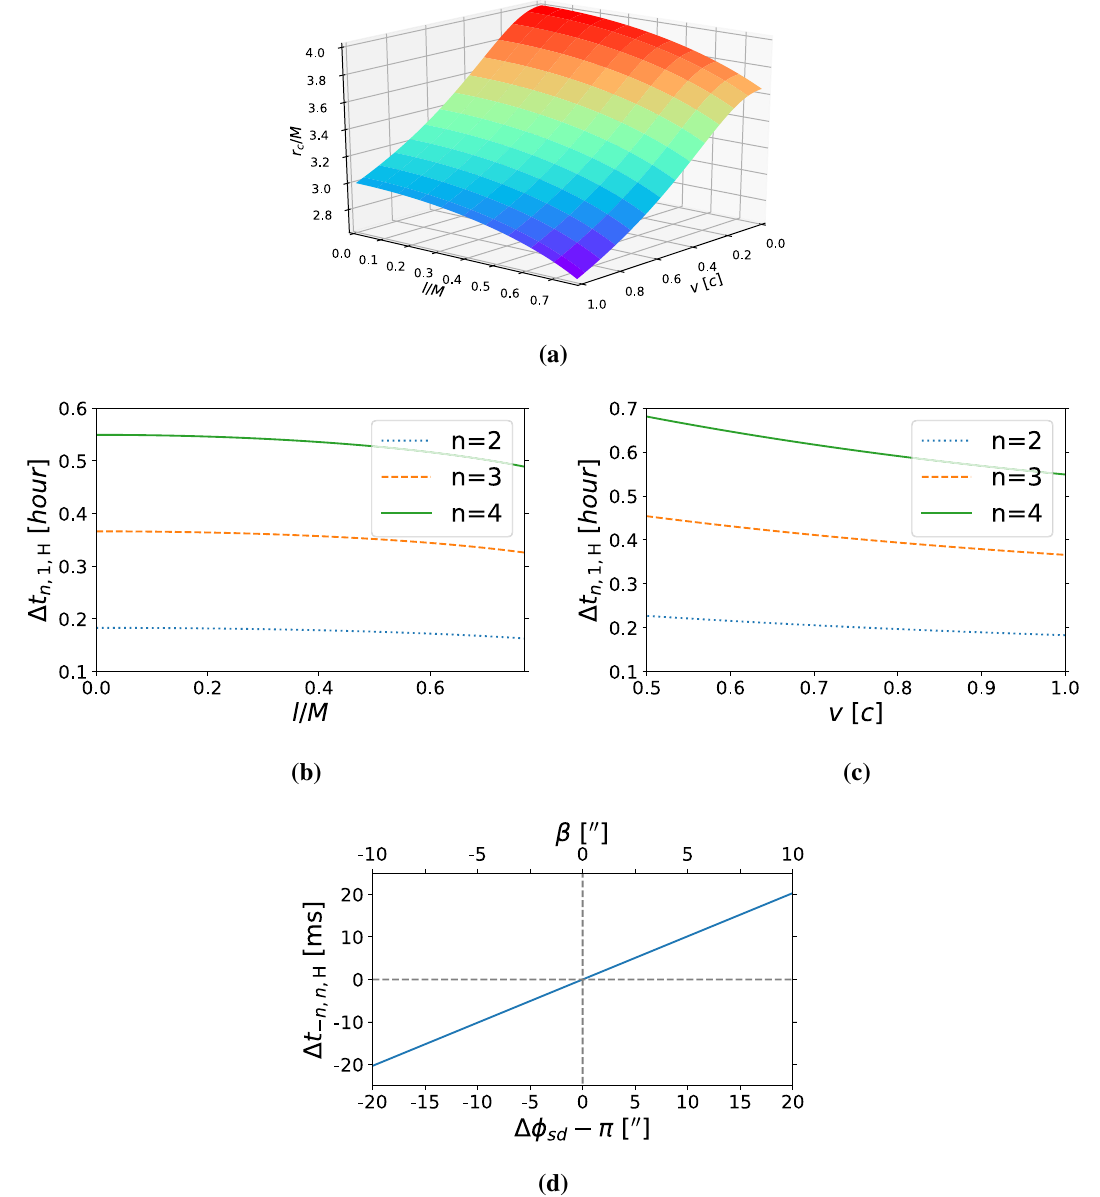
Fig. 3 a The radius of the particle sphere as a function of spacetimes parameter l and signal velocity v . Time delay between signals from same side but with different winding numbers as a function of: b l while holding v = 1 and; c v while holding l / M = 0 . 1. In d , the time